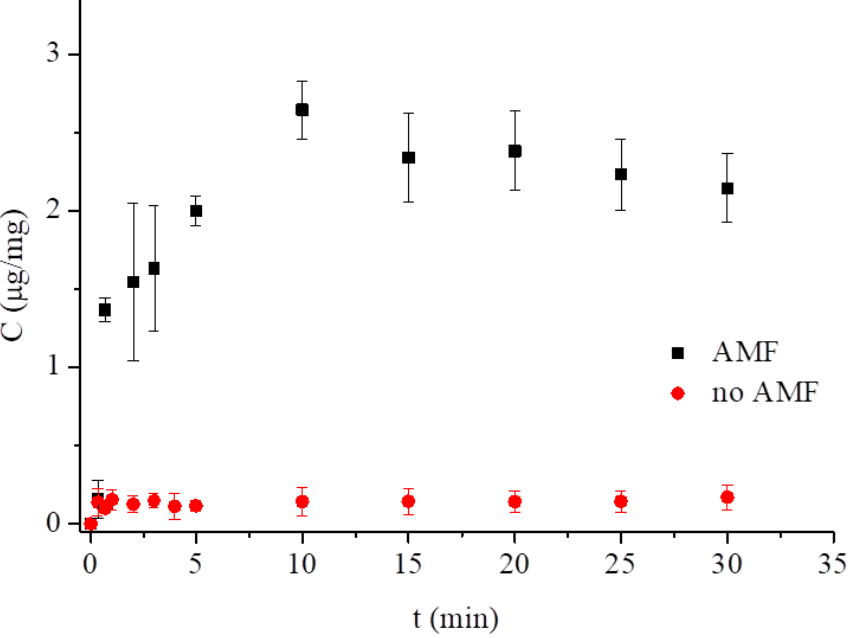
Figure 8. MTX released from magnetocubosomes vs. time, spontaneously and caused by LF-AMF at pH 7.4 and 25 °C.